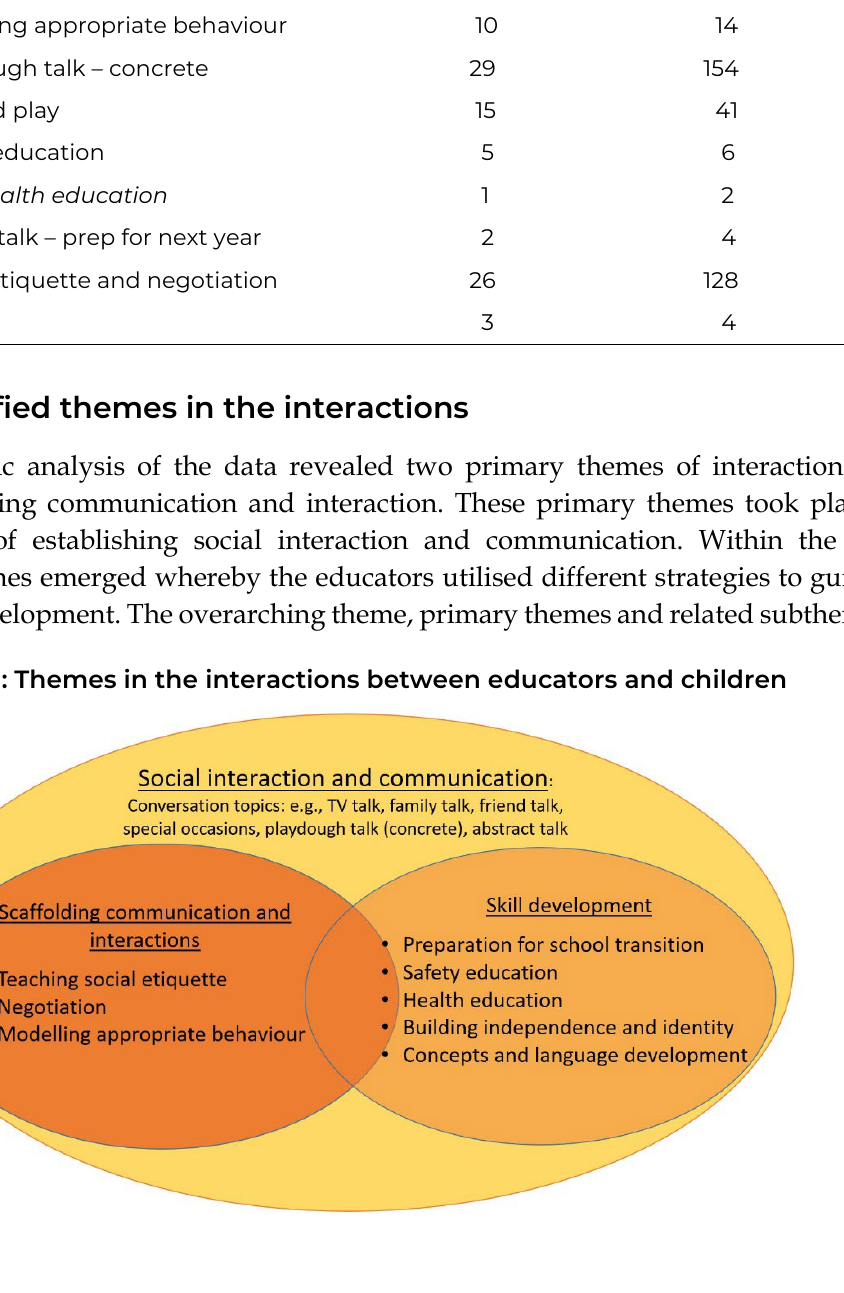
Social communication and